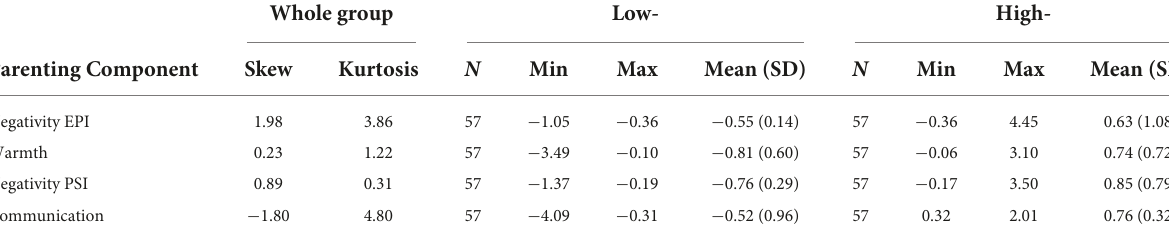
TABLE 2 Group information from family interaction macro-coding system principal components analysis ( n = 114). Whole